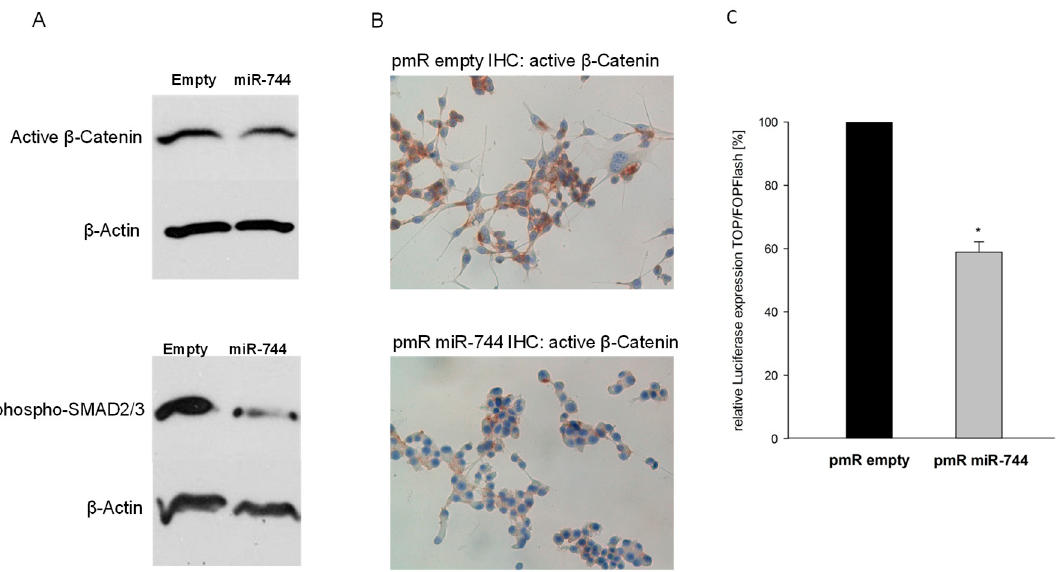
Figure 4. Stable overexpression of miR-744 represses activity of TGFB1 and DVL2 downstream effector molecules SMAD- and β -Catenin. Experiments were conducted after stable overexpression of miR-744 as compared to empty vector controls. ( A ) SDS-PAGE of active β -Catenin and phosphorylated SMAD 2/3. ( B ) Immunohistochemistry staining of active β -Catenin. ( C ) β -Catenin-dependent transcriptional activity of Lef/Tcf, measured with TOP/FOPFlash Luciferase Reporter Gene Assay (n = 4, p = 0.007). * p < 0.05.